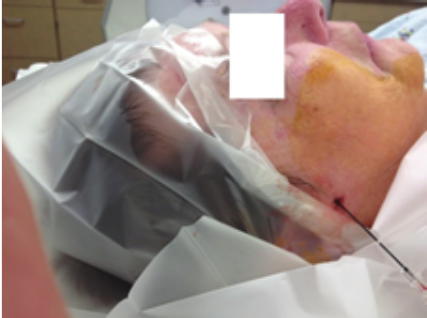
Figure 2: Location of needle insertion.